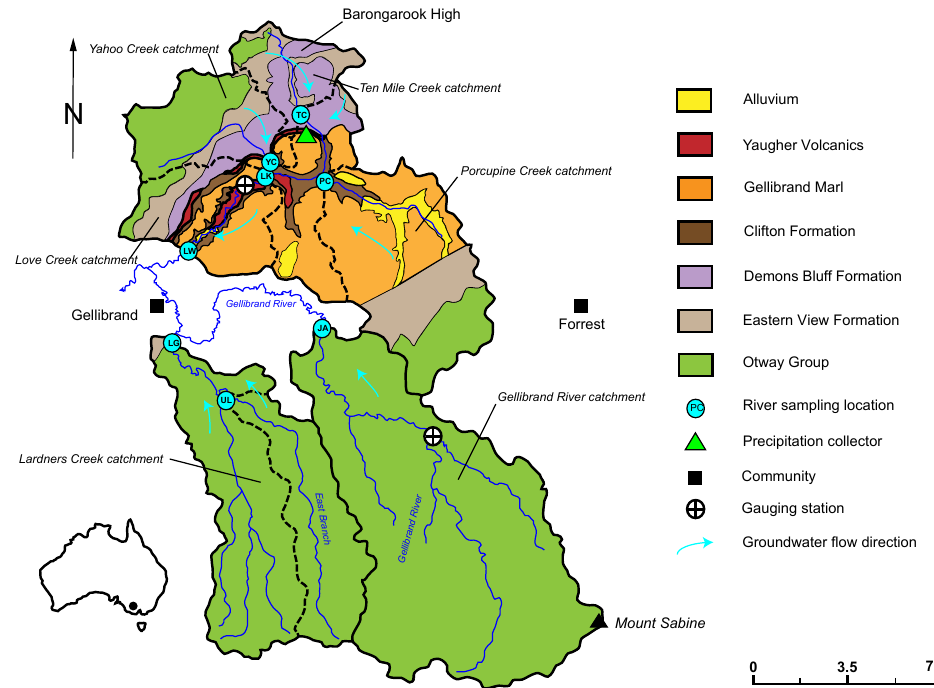
Figure 1. Map of study area showing catchments, sampling locations and bedrock geology. Inset map shows location of study area in Australia. Source: DataSearch Victoria (2015). LG = Lardners Gauge, UL = Upper Lardners, JA = Gellibrand River at James Access, PC = Porcupine Creek, TC = Ten Mile Creek, YC = Yahoo Creek, LK = Love Creek Kawarren, and LW = Love Creek Wonga. Current or discontinued gauging stations exist at all sites except for Upper